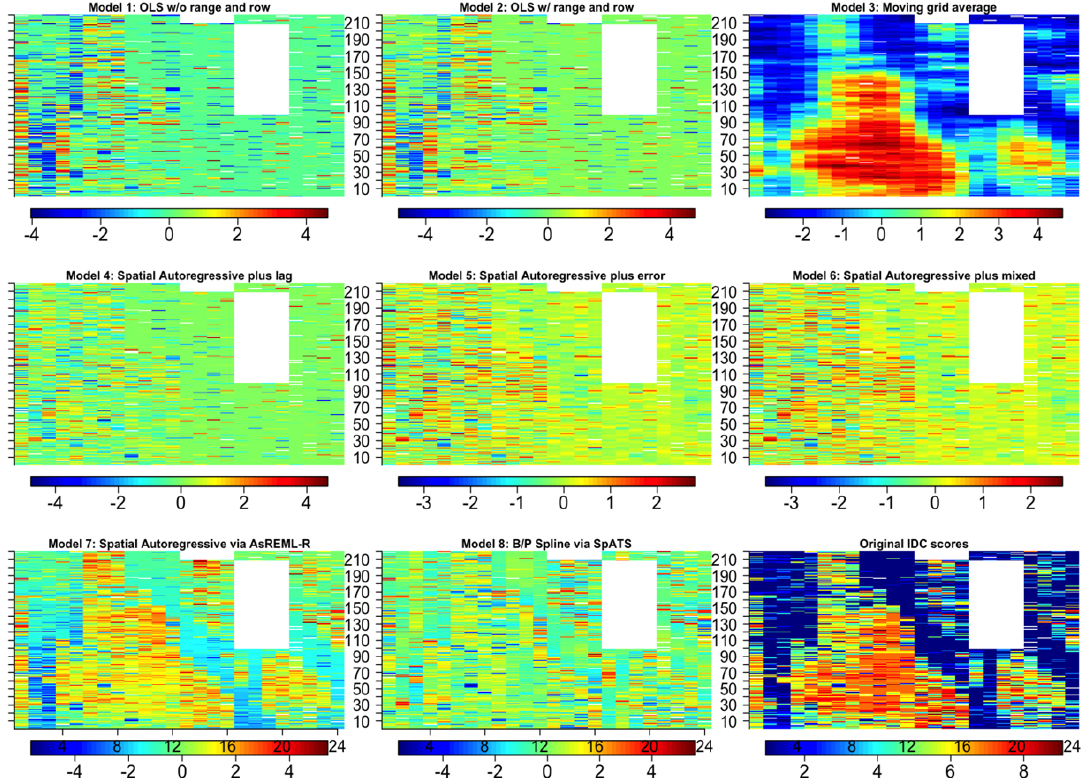
Figure 9. Heatmaps of the residuals from data set 3 derived from the eight models. Each of the images has filled in ranges by rows. The X -axis is the row, and the Y -axis is the range. The numbers under the legend bars are the range of residual values, and the numbers above the legend bars in the bottom half of the figure are the row numbers.